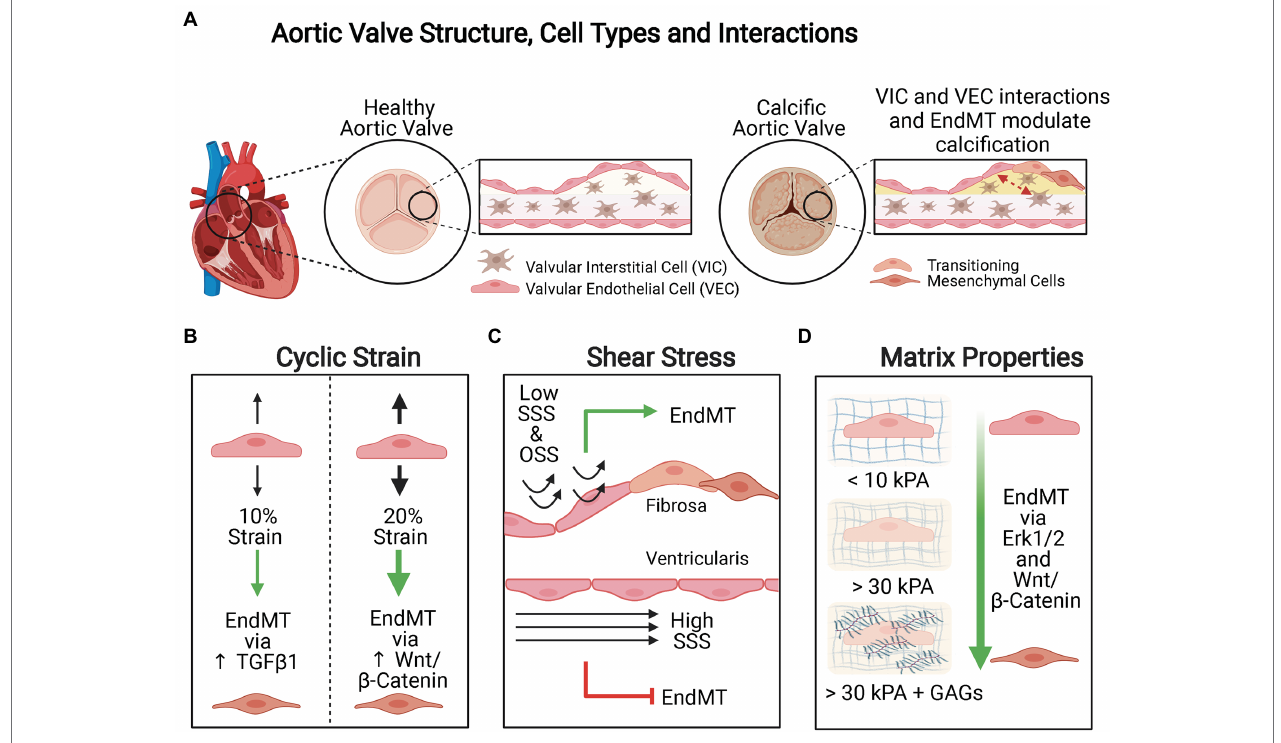
FIGURE 3 | Mechanical modulation of EndMT in valvular endothelial cells (VECs). (A) Aortic valve structure, cell types, and interactions. The aortic valve is a trilaminar structure with valvular interstitial cells (VICs) sandwiched in between two layers of VECs. Interactions between the VICs and VECs and EndMT are both important in valvular calcification. (B) Cyclic strain. Cyclic strain induces greater extent of EndMT when applied orthogonally to the alignment of the valve endothelium and the pathways activated are magnitude dependent. When VECs are subject to 10% cyclic strain, EndMT is activated via TGF β 1 signaling, whereas 20% cyclic strain promotes EndMT via Wnt/ β -Catenin signaling. (C) Shear stress. Low steady shear stress (SSS) and oscillatory shear stress (OSS) promote EndMT, whereas high SSS is protective against EndMT. Calcification is more common on the fibrosa side where VECs are exposed to low SSS or OSS than on the ventricularis side where VECs are subject to high SSS. (D) Matrix composition and stiffness. Increasing matrix stiffness and increased glycosaminoglycans (GAGs) content promote